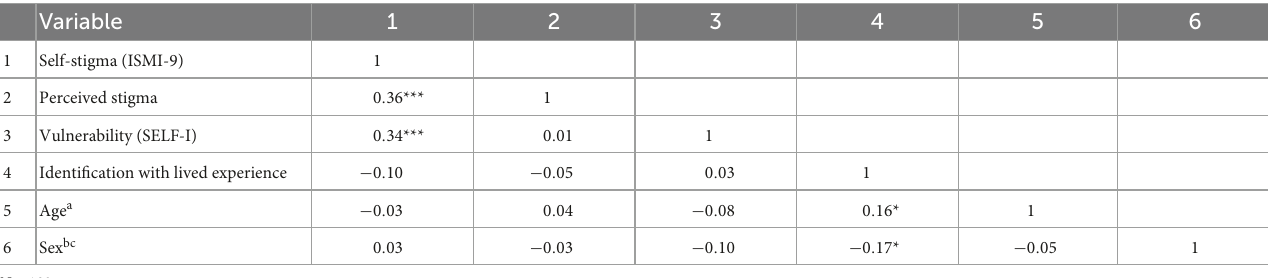
TABLE 3 Correlations between study